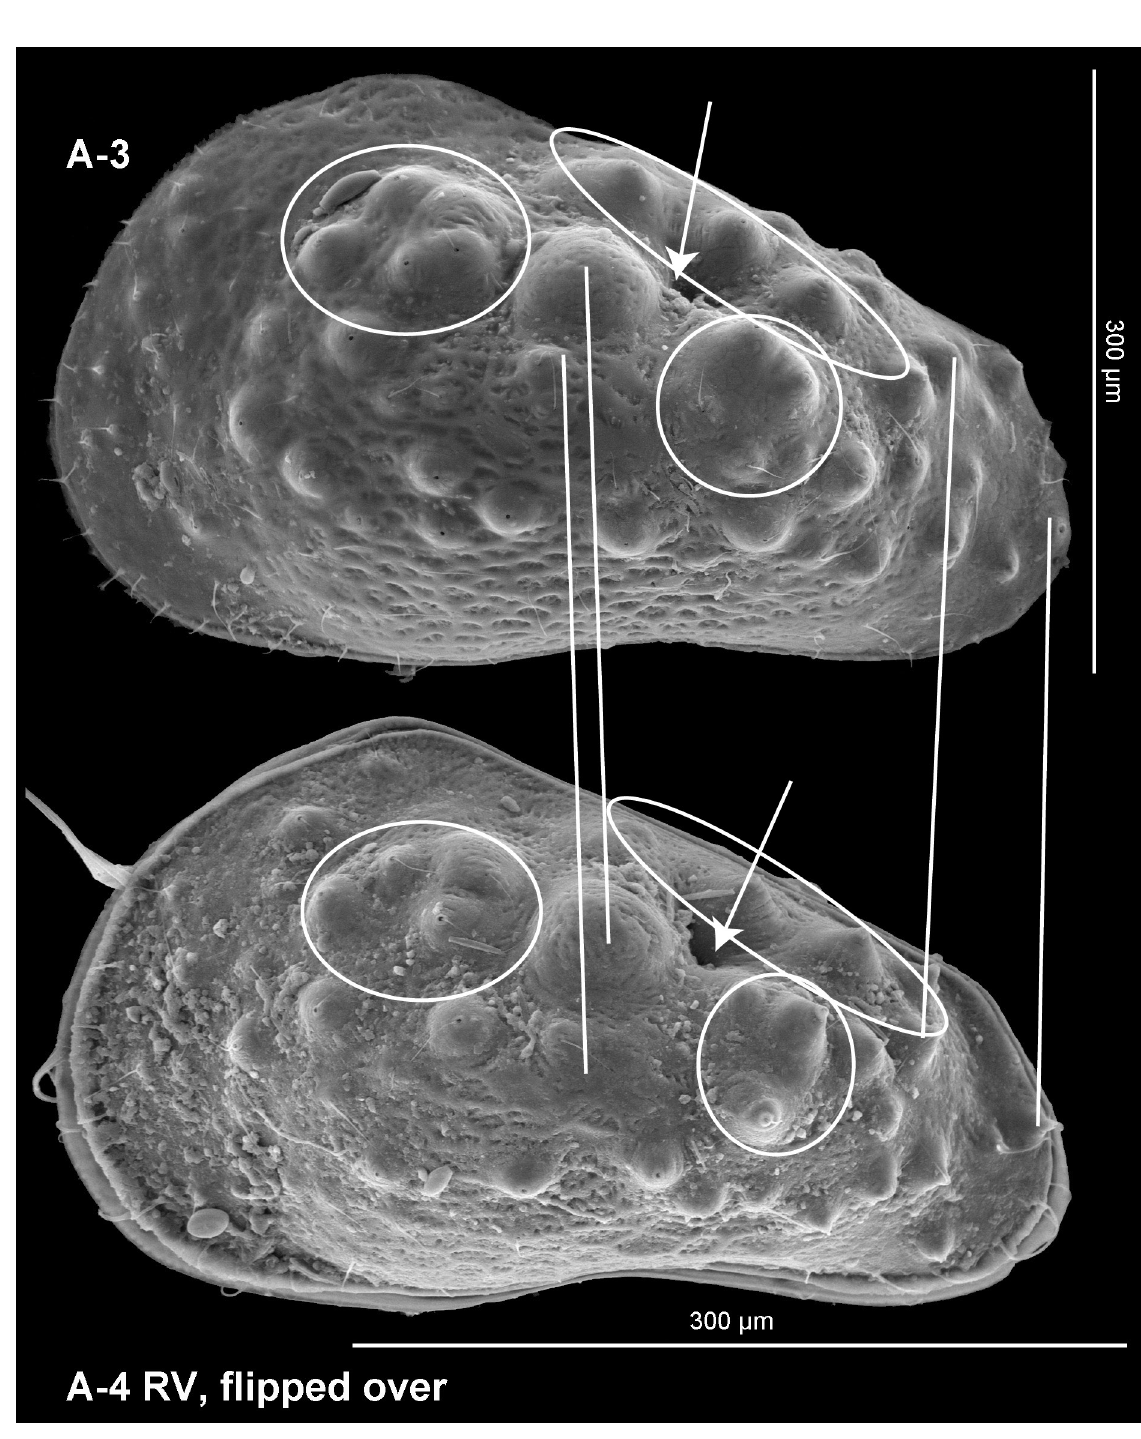
Fig. 9. External views of carapaces of Bennelongia cf. nimala nov. sp. juveniles from Muggon Lake. The top image shows an A-3 left valve, whereas the bottom image shows a RV of an A-4 specimen that has been ‘flipped over’ digitally, so as to permit comparison of the type of external ornamentation and respective location. The white lines (straight as well as circles and ellipses) permit direct comparison between features. Note the presence of particulate matter as well as diatoms, stuck to the anterior portion of the (flipped over) A-4